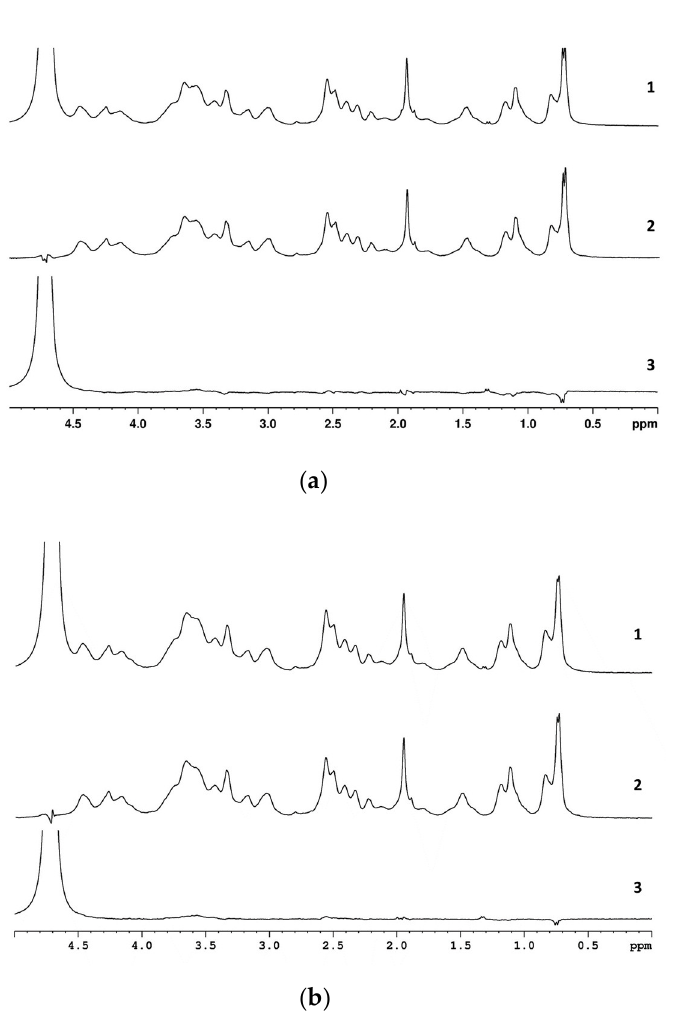
Figure 3. 1D-DOSY spectra of succinyl chitosan-colistin conjugate (SucCS-CT-10) in D 2 O/TFA ( a ) and in PBS/D 2 O/TFA ( b ): g = 5% (1); g = 90% (2); difference spectrum (3). Table 2. Physico-chemical properties of the succinyl chitosan-colistin conjugates.